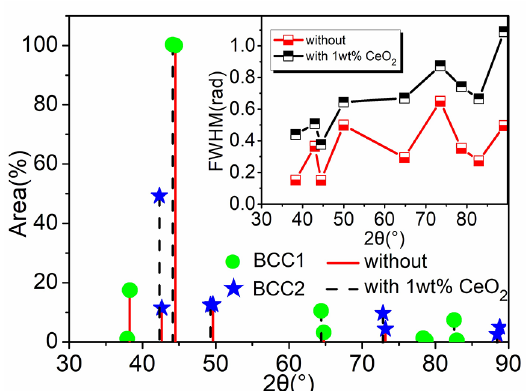
Figure 2. The diffraction peak area and FWHM of BCC1 and BCC2 for AlCoCuFeMnNi without and with 1wt% CeO